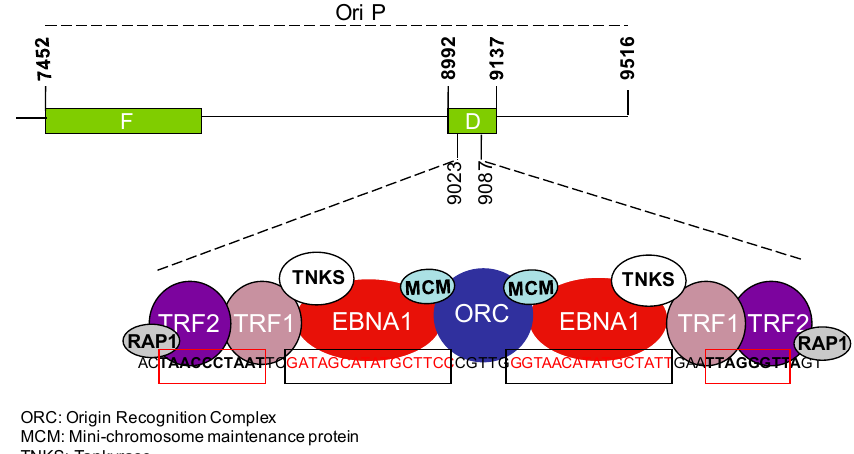
Figure 4. Schematic illustration of the Epstein Barr virus (EBV) OriP and interacting viral and telomeric proteins. Organization of the OriP region where the family of repeats (F) and dyad symmetry (DS) regions are indicated. The enlarged region within the DS contains two EBV nuclear antigen (EBNA)1 binding sites (black box) adjacent to telomere-like sequences (red box) where EBNA1 and telomere-associated proteins bind and recruit proteins, such as Origin Recognition Complex (ORC) and MCM, that are involved in viral genome replication and maintenance. TRF1-interacting protein, TNKS, interacts with EBNA1 and regulates OriP replication.